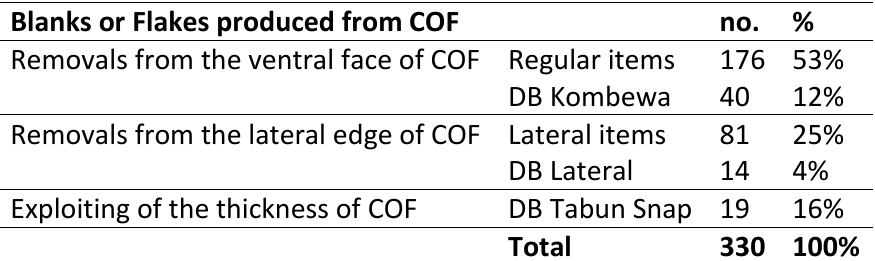
Figure 8 . A flow chart describing the recycling of blanks into COFs and the products of recycling - flakes and blanks produced from the COFs. Table 3: Types of Blanks or Flakes produced from